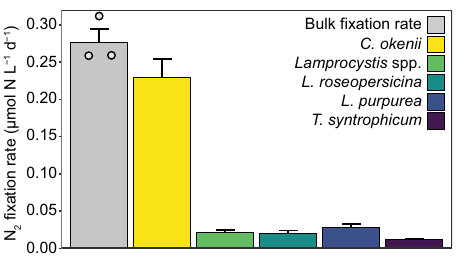
Fig. 5 Total N 2 fi xation rates of investigated PSB in comparison to bulk N 2 fi xation rate in 13.7 m water depth. The bulk rate is shown as the average of the triplicate incubations, with the error bar representing the standard deviation. Gray circles represent the individual replicates. Population-speci fi c rates were calculated based on the average cell abundance and average single-cell N 2 fi xation rate. Here, error bars represent the propagated standard error of the cell abundance and the single-cell N 2 fi